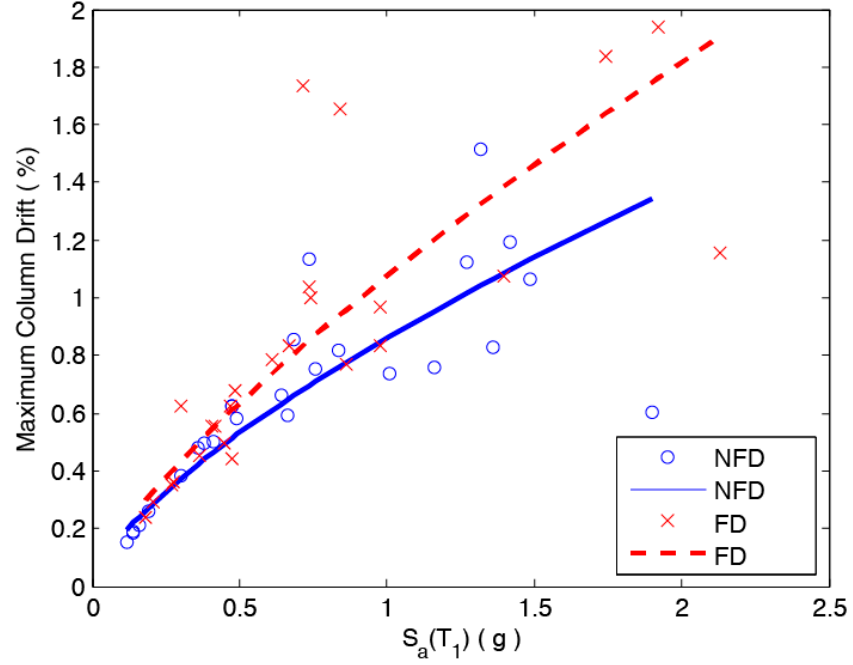
Figure 8. Plots of bridge responses to forward directivity (FD) and non-forward directivity (NFD) ground